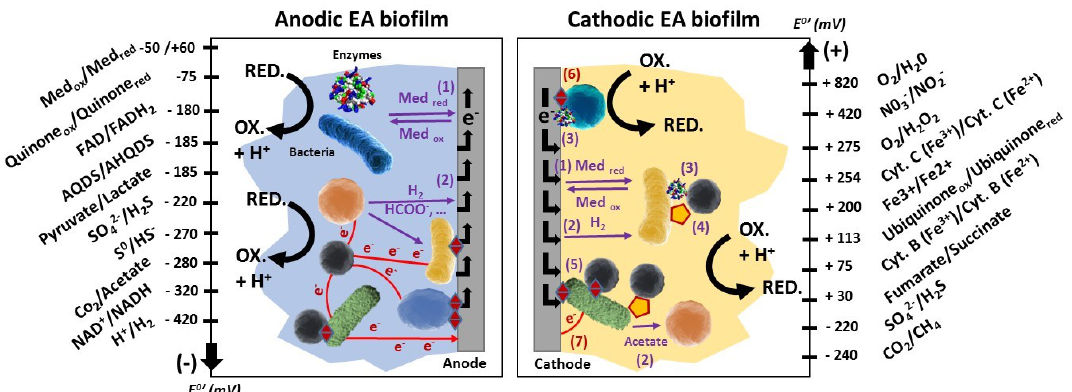
Figure 1. Overview of the bacterial external electron transfer (EET) mechanisms described in the literature and operating individually or in combination in anodic and cathodic biofilms. This figure was adapted from Aghababaie et al. 2015 [8], Santoro et al., 2017 [9], and Blasco-Gomez et al., 2017